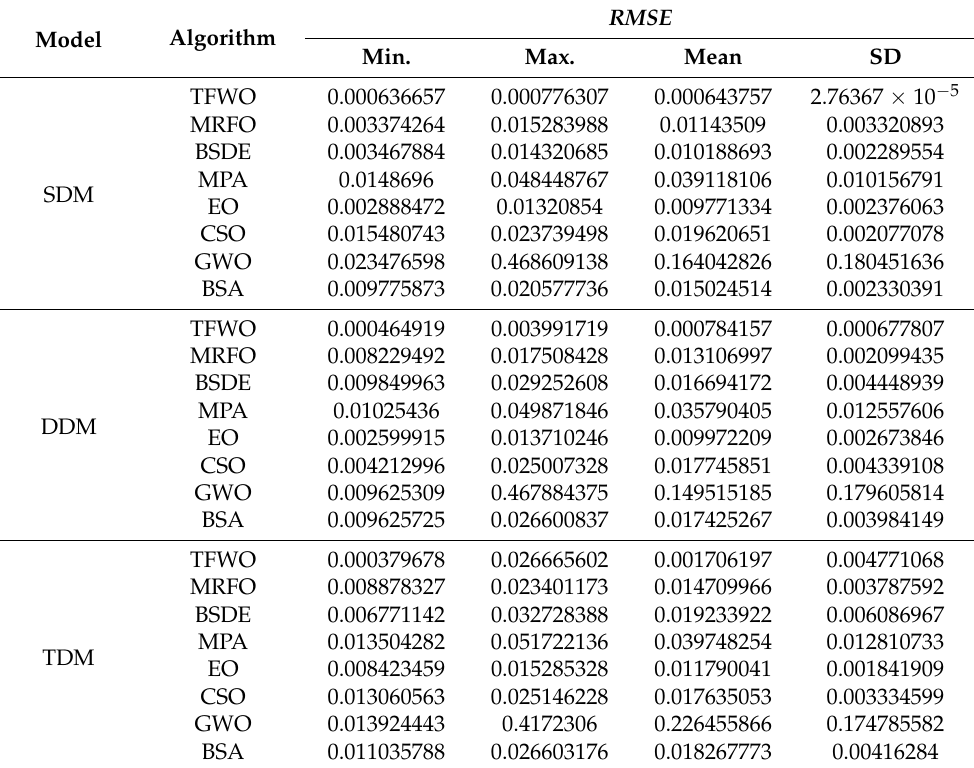
Table 12. Statistical analysis of RMSE for KC200GT module with SDM, DDM, and